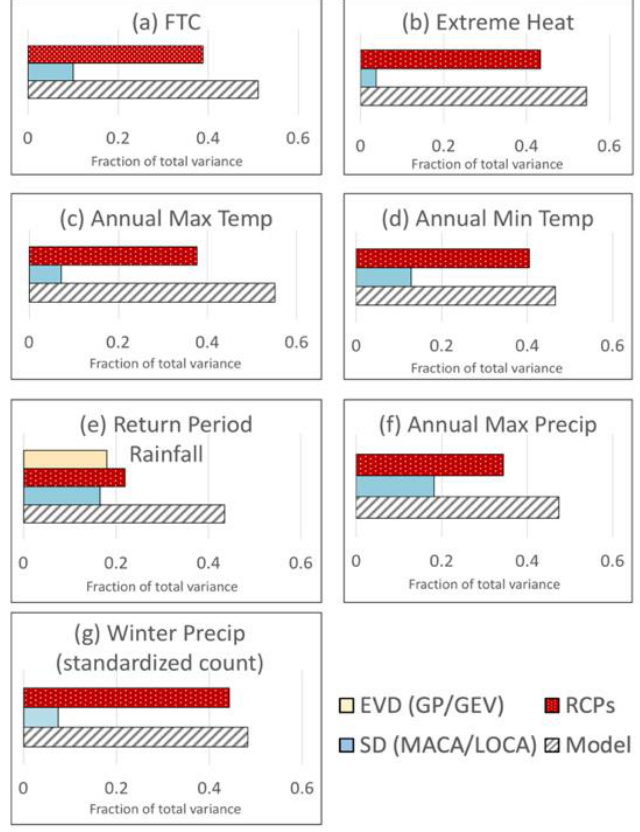
Figure 9. Contributions of various aspects of a climate projection to total variance of each metric shown in ( a – g ). Model variance is the variance between model projections by the late 21st century using both RCP4.5 and RCP8.5, based on the MACA SD method only; emissions variance is the variance of the difference between late 21st century projections from RCP4.5 and RCP8.5; SD variance is the variance of the differences between MACA and LOCA simulations for all overlapping models. Lastly, extreme value distribution (EVD) variance is the difference between the 100-year return period magnitudes of daily precipitation (GP minus GEV) obtained for both future reference periods, and emissions scenarios. The plots show the fractional contributions of each variance type, with more details of this approach given in Supplementary Materials, Table S3.